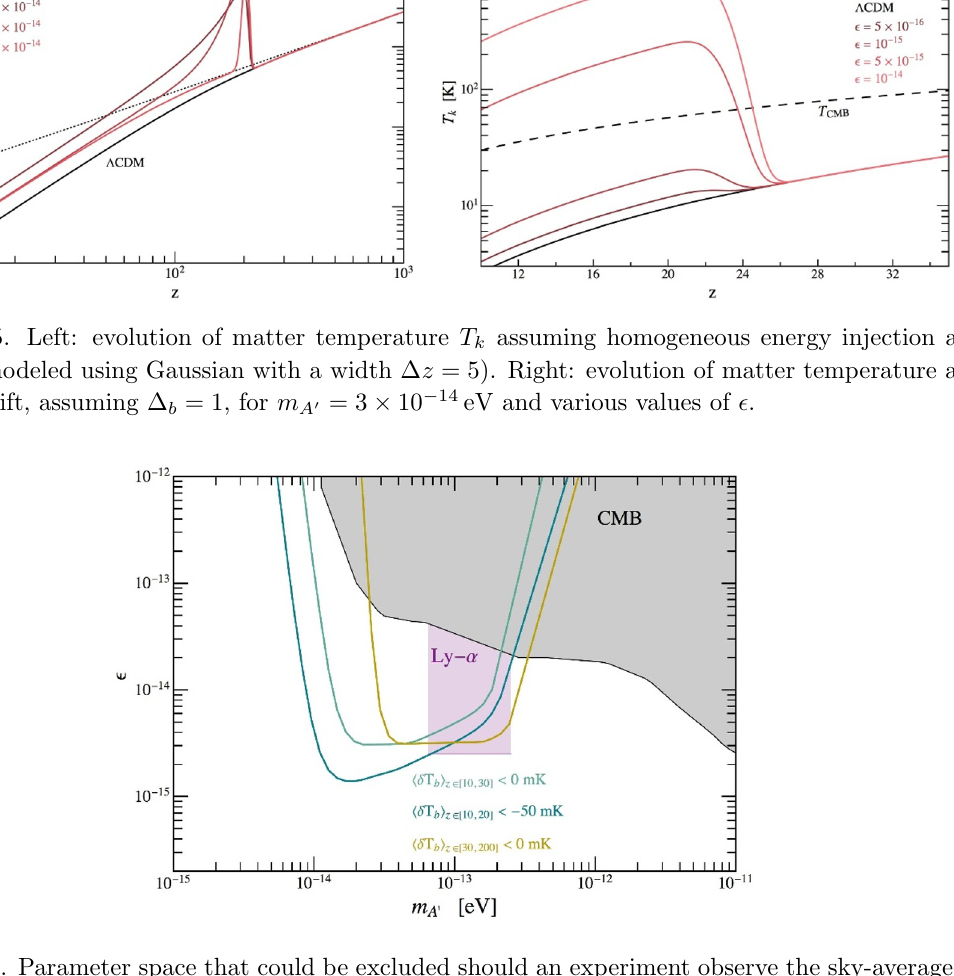
Figure 6 . Parameter space that could be excluded should an experiment observe the sky-averaged 21cm temperature in an interval z 2 [ z min ; z max ] with an amplitude less than or equal to some threshold (being here 0 mK or (cid:0) 50